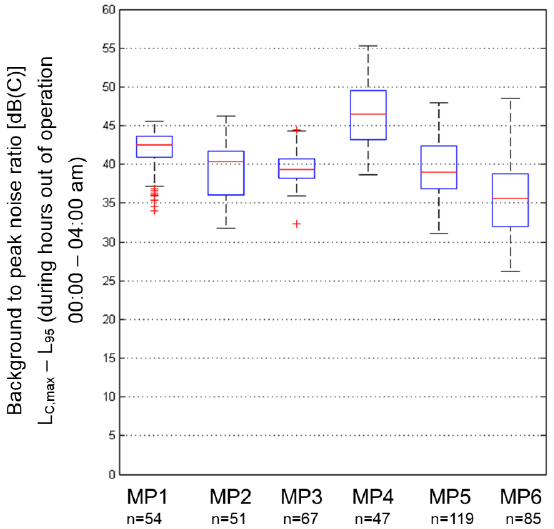
Figure 7. Background to peak noise ratio C ‐ weighted: site comparison.